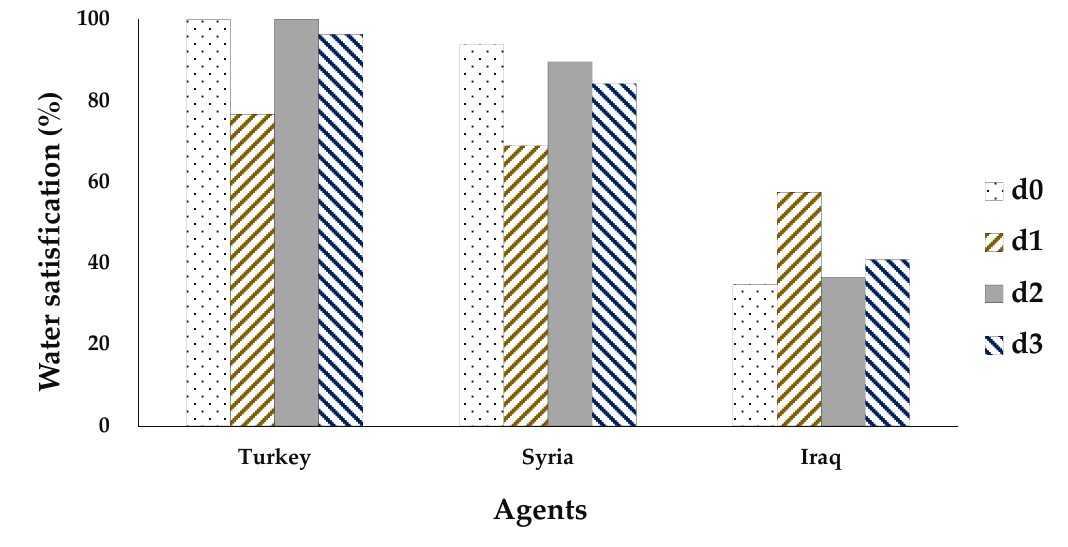
Figure 4. Water satisfactions (%) of three agents under two Nash bargaining solutions considering different DUP vectors and two bargaining weights of 1 and ω NP . d0: indicates that the agents’ DUP vector is 0; d1 indicates that the agents’ DUP vector is determined by MTBT; d2 indicates that the agents’ DUP vector is determined by MRDC; d3 indicates that the agents’ DUP vector is determined by MENP.